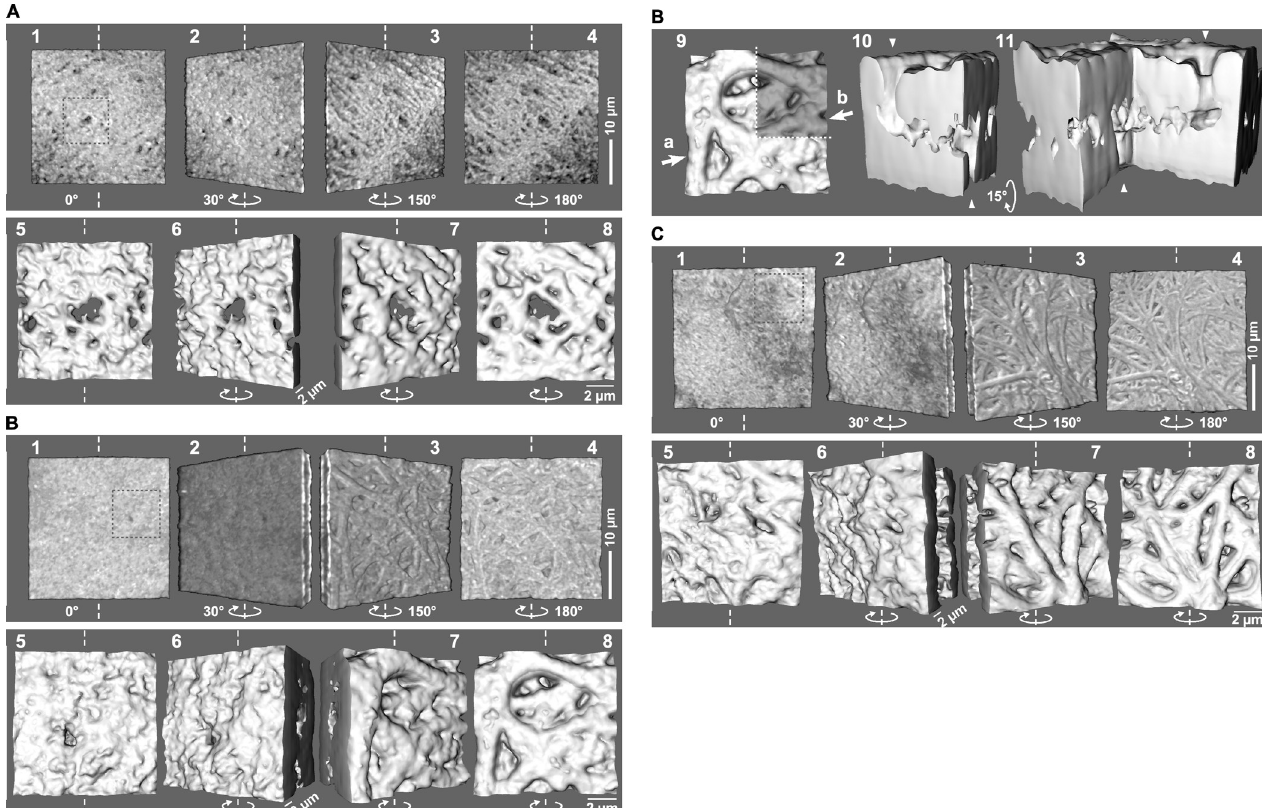
Fig 1. 3D-surface morphologies of egg-coat matrices in IPVLs isolated from different growing stages of ovarian follicles. IPVLs of the commercial White- Leghorn hens were isolated from the yellow follicles F3 (A), F2 (B), and F1 (C), and 3D images of them were obtained by the indirect immunofluorescence staining with the primary antibody against the repeat (avian Pro/Thr/Leu-rich) region of chicken ZP1 and the Alexa Fluor 1 488-labeled secondary antibody, followed by a confocal laser scanning microscopy. Thirty-micrometer squares of the IPVLs were rendered as the 3D-volume images with rotational angles of 0˚, 30˚, 150˚, and 180˚ indicated by white elliptic arrows from one surface displaying smooth or homogeneous microstructures to the other surface displaying fibrous microstructures along the vertical white dashed lines ( panels 1–4, respectively). Ten-micrometer squares shown by gray dotted lines inside the 30- μ m square images ( panels 1) were rendered as the magnified 3D-surface images with similar rotational angles ( panels 5–8, respectively). For the F2 IPVL (B), the cross-section along the white dotted lines in the panel 9 was also rendered as 3D-surface images from the viewpoints shown by white arrows a and b in it with look-down angles of 15˚ indicated by white elliptic arrows ( panels 10 and 11, respectively; white arrowheads indicate the traversing tunnel). Thicker bars ( panels 4): 10 μ m. Thinner bars ( panels 6 and 8): 2 μ m.